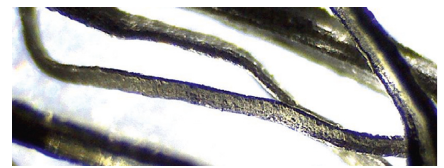
Figure 14: Surface texture of steel fiber.